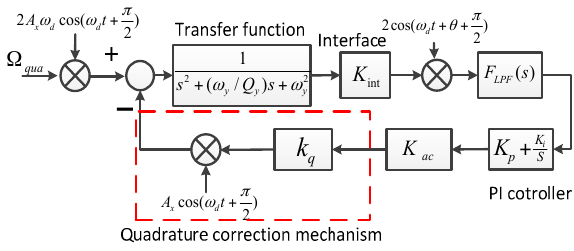
Figure 10. Scheme of the closed-loop quadrature correction control system.